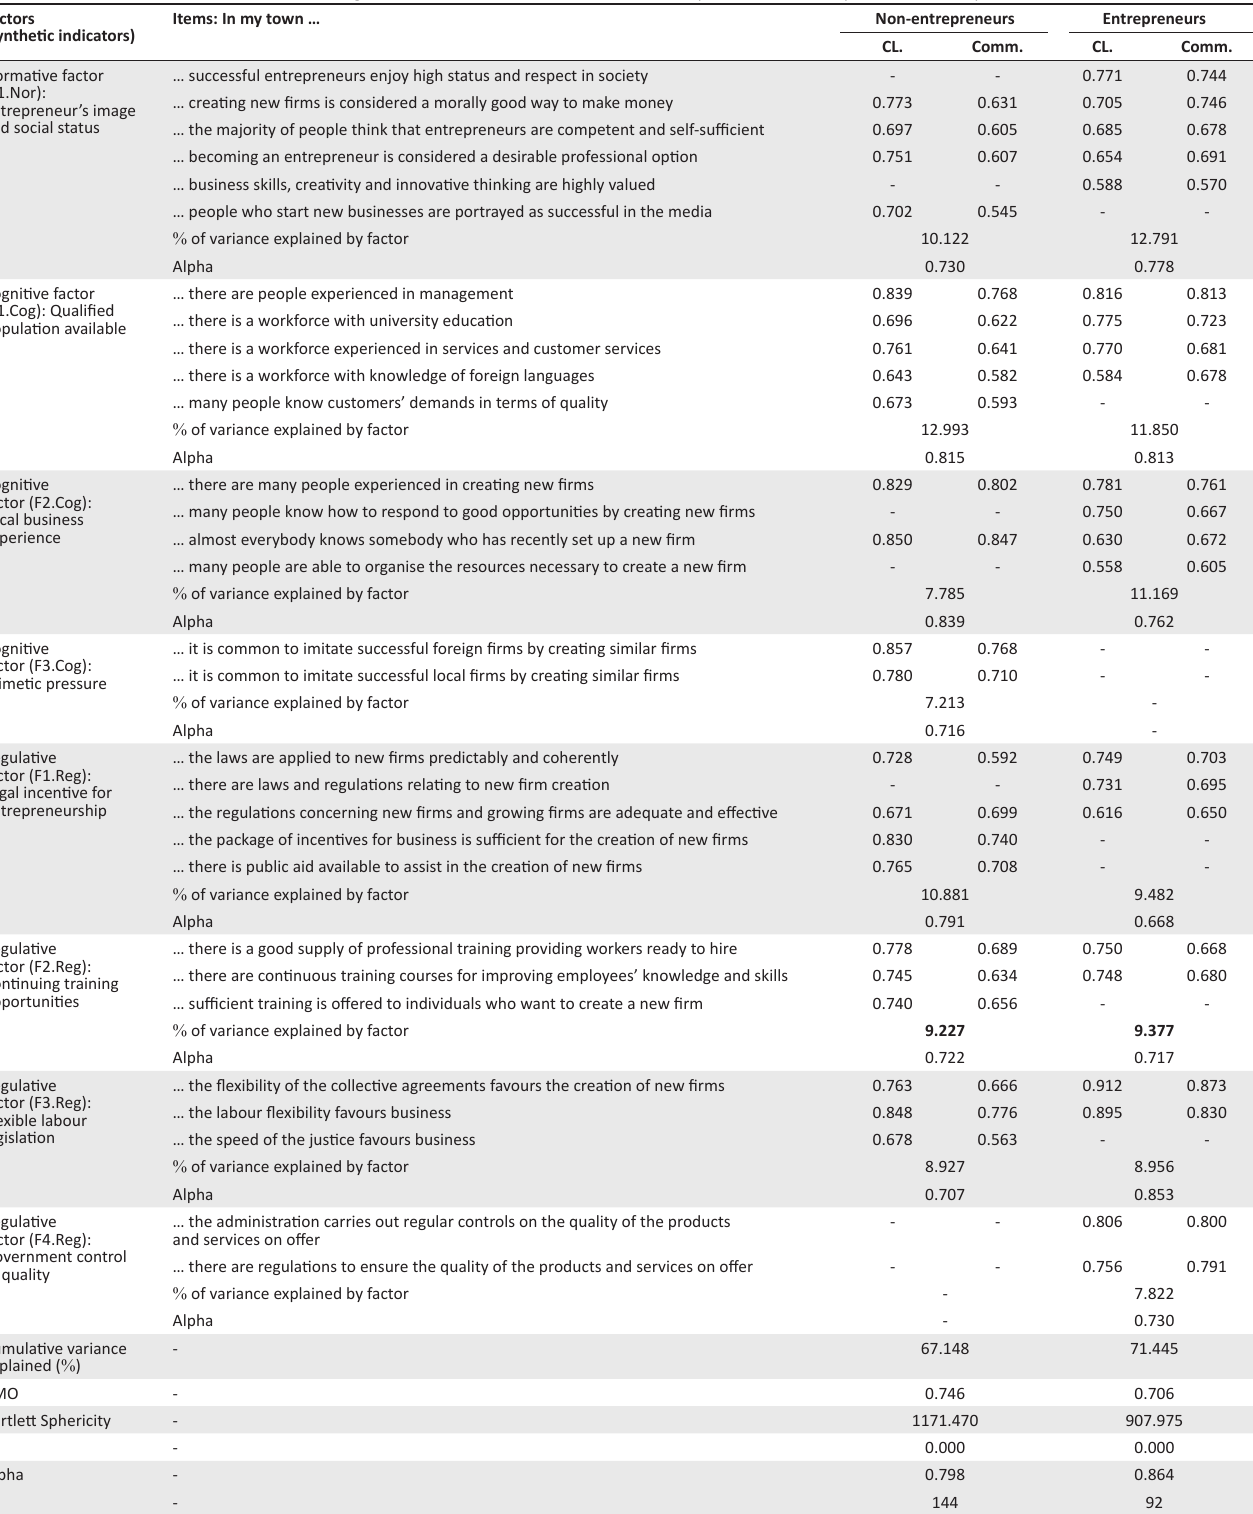
TABLE 1-A2: Institutional dimensions scale. Configuration matrix from SPSS Pc 17.0: Non-entrepreneurs and entrepreneurs subsamples. Factors (synthetic